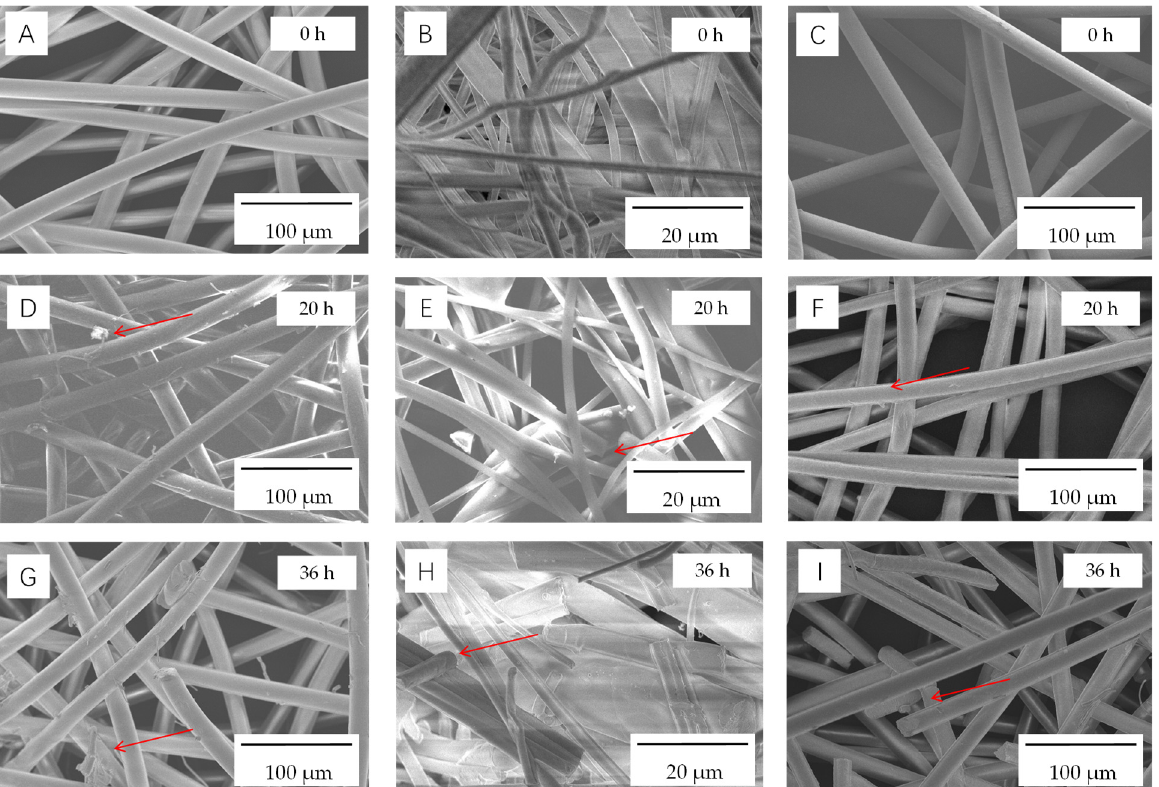
Figure 3. Representative SEM images showing the changes in the surface morphology of different layers of the mask after 0 h, 20 h, and 36 h of UV irradiation. ( A ) Outer layer without UV irradiation; ( B ) middle layer without UV irradiation; ( C ) inner layer without UV irradiation; ( D ) outer layer with 20 h of UV irradiation; ( E ) middle layer with 20 h of UV irradiation; ( F ) inner layer with 20 h of UV irradiation; ( G ) outer layer with 36 h of UV irradiation; ( H ) middle layer with 36 h of UV irradiation; and ( I ) inner layer with 36 h of UV irradiation. Red arrows represent the aging position of the fibers.